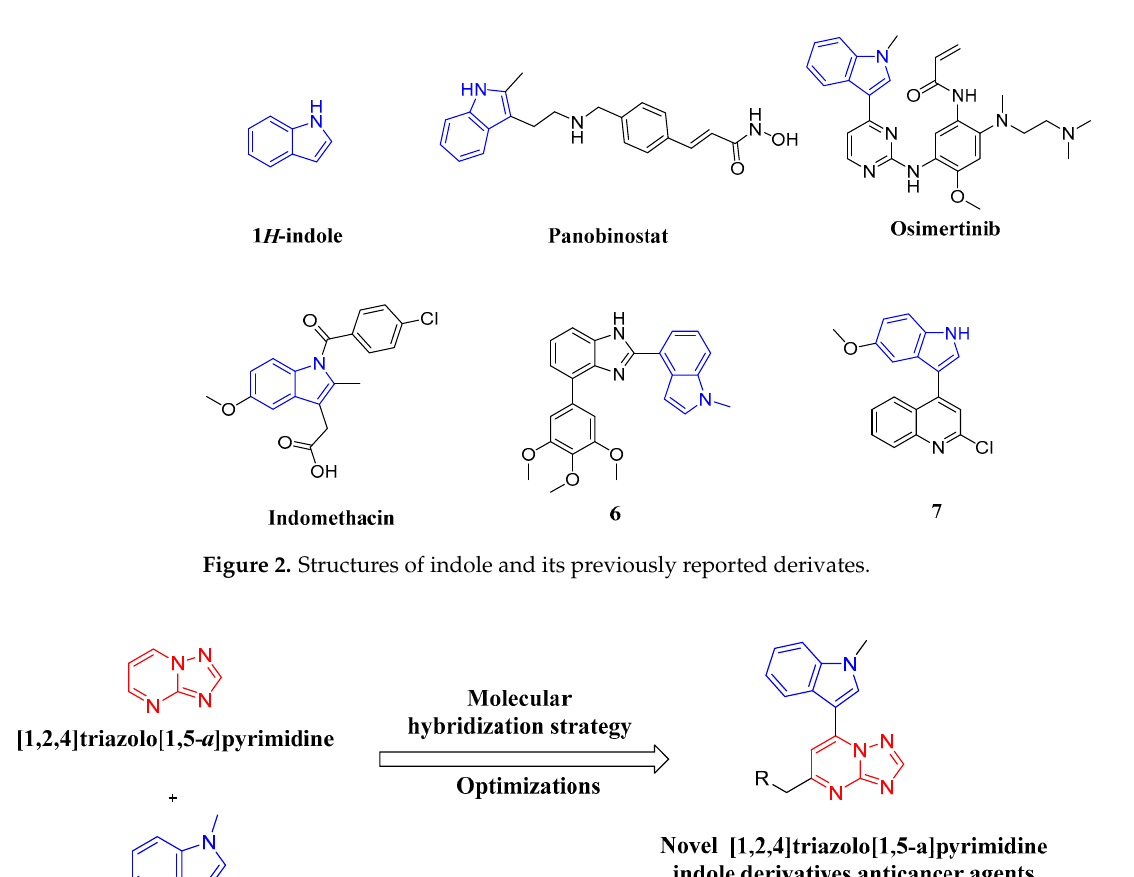
Figure 2. Structures of indole and its previously reported derivates.